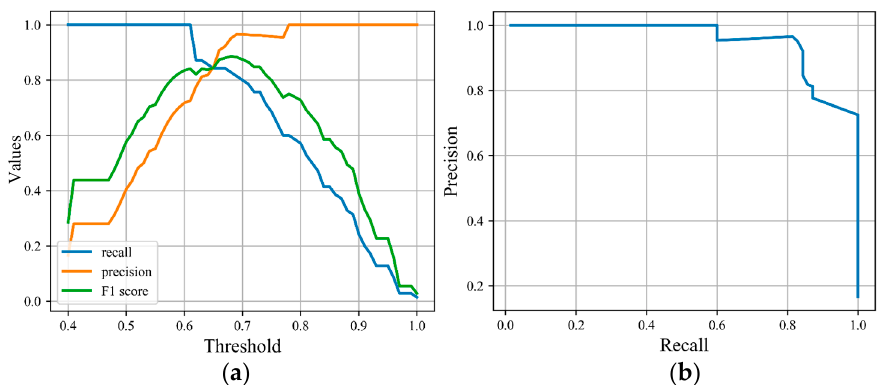
Figure 12. Accuracy assessment of optimal model results. ( a ) The recall, precision, and F1 score vary with the confidence threshold value. ( b ) Precision–recall curve for optimal model.